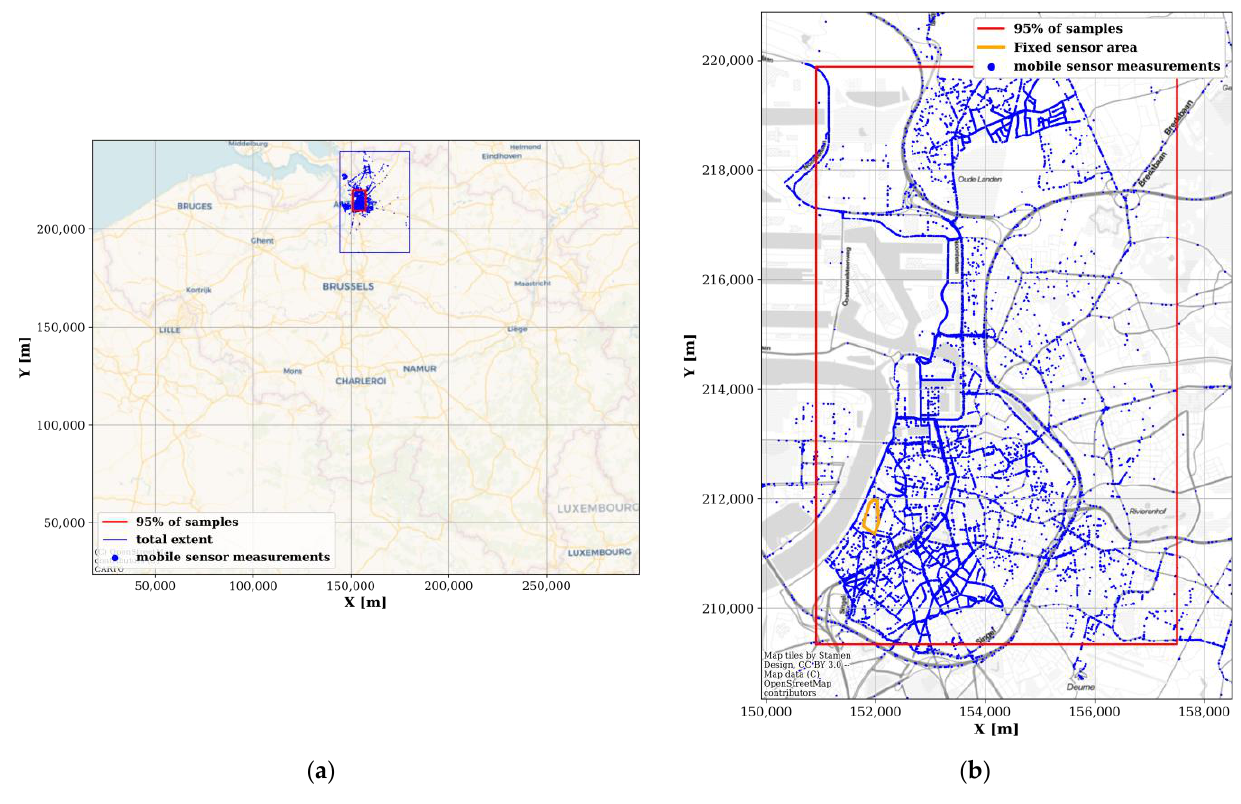
Figure 3. Extent of the mobile RF sensor measurements (blue dots). ( a ) Area covered by the mobile RF sensors (blue rectangle) in comparison to Belgium. ( b ) Zoom of the covered area, with sample locations after processing the GPS data as shown in Figure 4 [16]. The area bounded by the red rectangle contains 95% of the measurement locations. The area bounded by the orange polygon is the area bounded by the fixed sensor network (Figure 2a) (coordinate system: Belgian Lambert 1972).